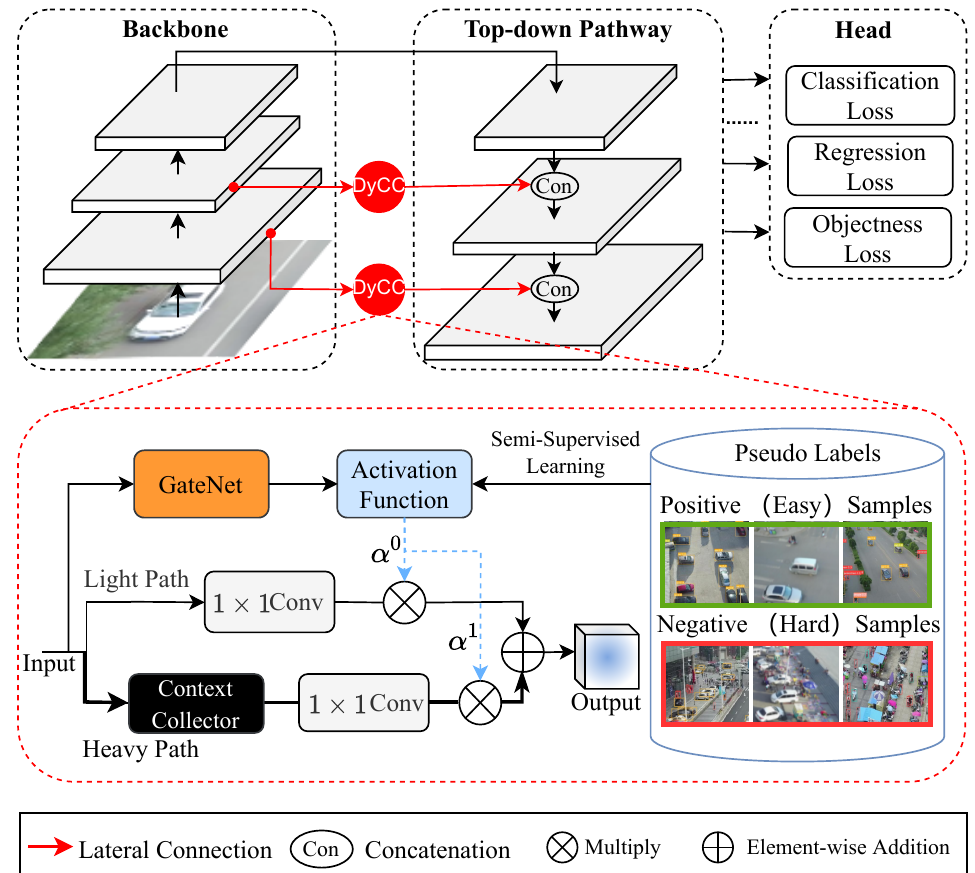
Figure 2. The pipeline of DyCC-Net is composed of four modules, i.e., a feature-extraction Backbone module, our input-aware DyCC module, a top–down multi-scale features-extraction pathway, and a Head for estimating bounding box positions and classification